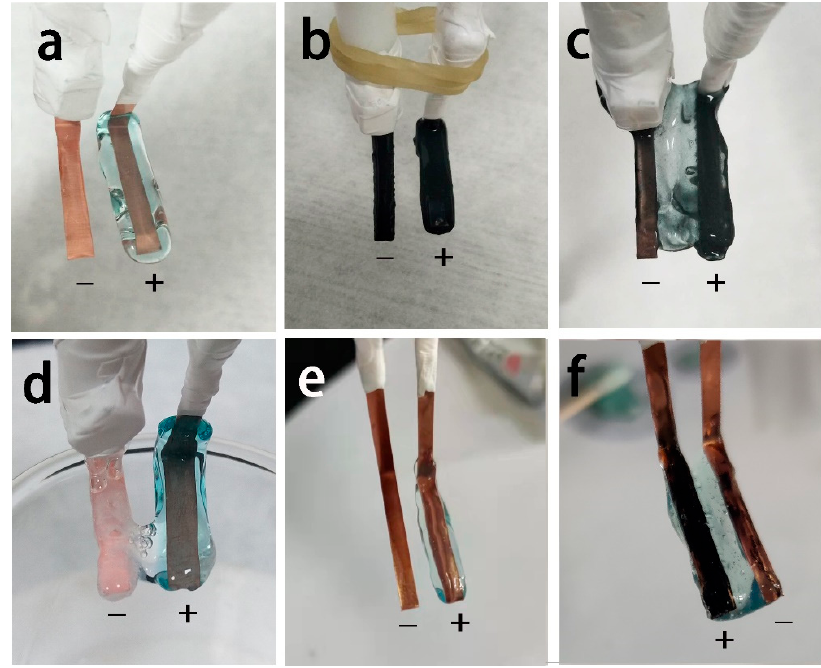
Figure 3. Photographs of ( a ) the chitosan/Cu 2+ ion anodic film deposited on Cu-Cu electrodes at − 0.5 V; ( b ) the chitosan/C anodic film deposited on Cu-Cu electrodes at − 0.5 V; ( c ) the chitosan freestanding hydrogel film deposited on Pt-Pt electrodes at − 0.5 V; ( d ) the chitosan/Cu 2+ ion hydrogel deposited at − 0.8 V; ( e ) the chitosan/Cu 2+ ion film deposited on Cu-Cu electrode at − 0.2 V; ( f ) the chitosan freestanding film deposited on Cu-Cu electrodes at − 0.2 V.